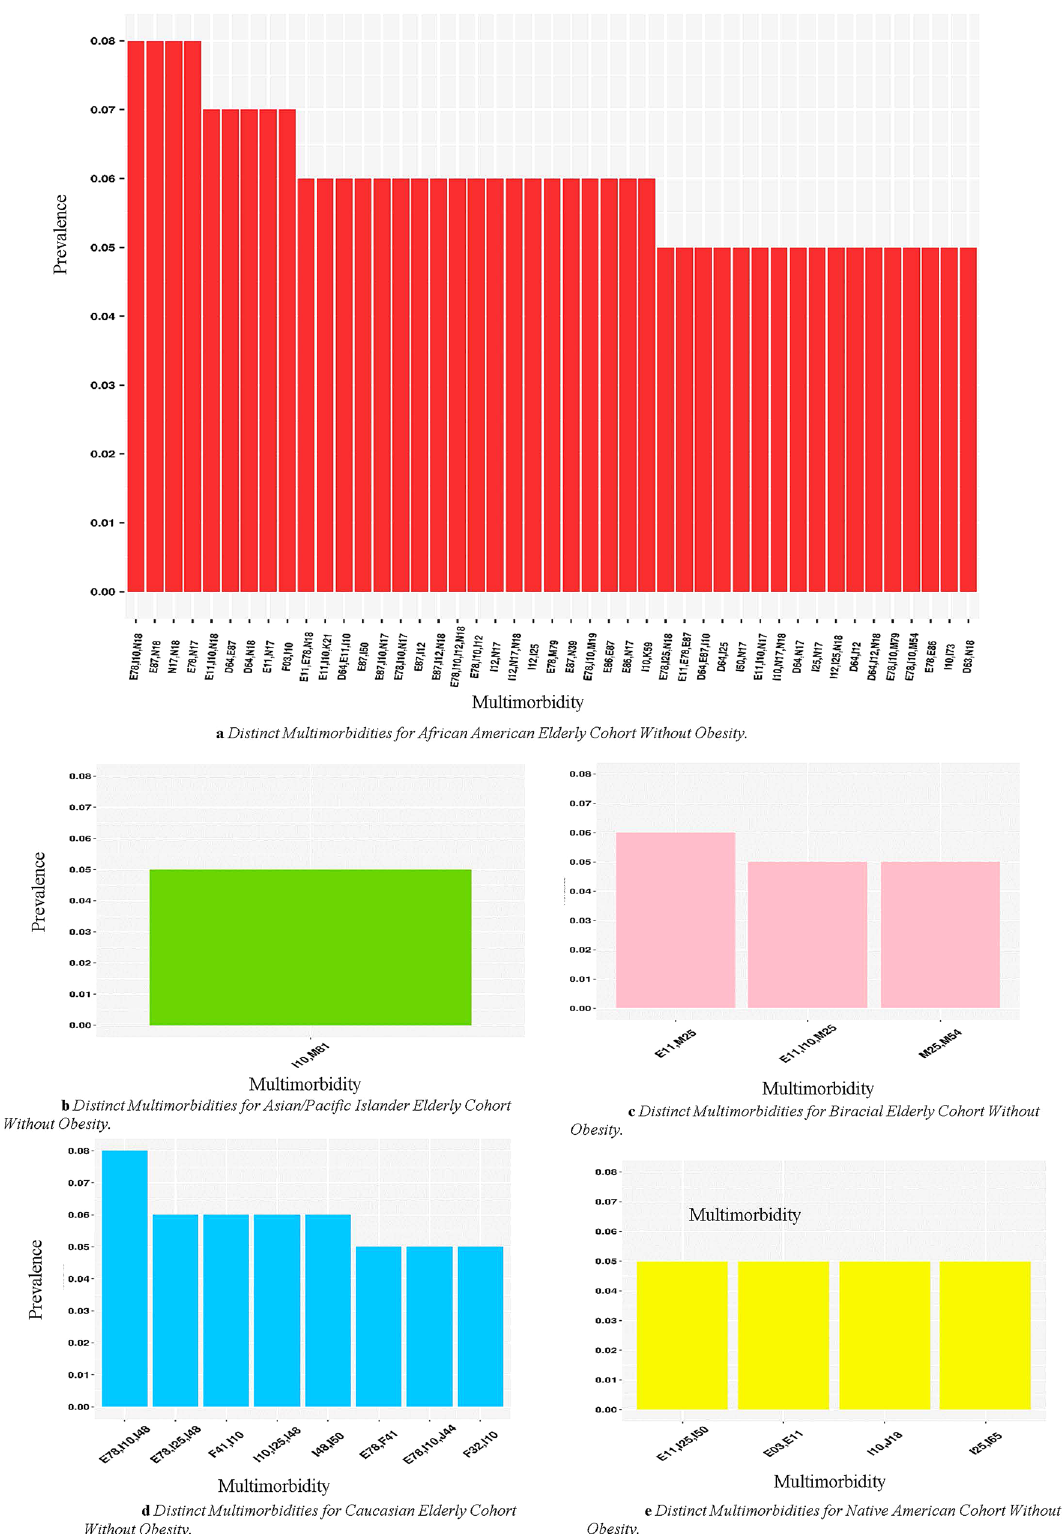
Figure 4. ( a – e ) Demonstrate distinct multimorbidities across races in elderly patients without obesity at 5% prevalence threshold. Disease Clinical Categories; D: Blood and immune mechanism disorders, E: Endocrine, nutritional and metabolic, F: Mental, behavior and neurodevelopmental, G: Nervous System, I: Circulatory system, J: Respiratory system, K: Digestive system, N: Genitourinary system, M: musculoskeletal system and connective tissue. The g-test of independence was calculated resulting in all significant results with p <